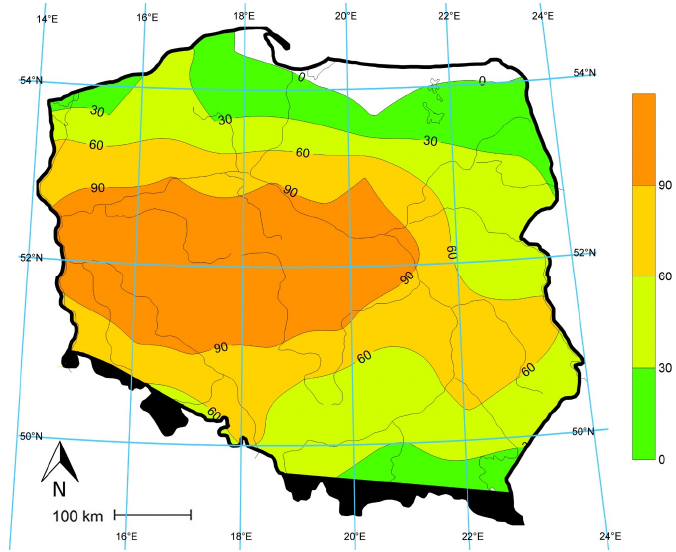
Figure 2. Duration of sequences of days with low precipitation frequency during summer (June–August) 2019. White color—phenomenon does not occur. Black color areas above 500 m above sea level. 3.3. Percentage of Normal Rainfall June–August 2019 From June to August 2019 in the South Baltic Lakes belt and the Central Polish Low- lands, precipitation totals were 30–60% of normal with a minimum of 30.1% in Pozna ń . Slightly higher values of precipitation occurred in the western part of the South Baltic Coast and Lake Districts belt within 70–90% of the norm. Values exceeding 90% of the precipitation norm occurred in the southern part of the Sudety Mountains with the Sude- ten Foreland, in the northern part of the Ma ł opolska Upland, in the western part of the Outer West Carpathians, and in the eastern part of Poland. The highest values of precipi- tation were recorded in the eastern part of the South Baltic Coast, the Eastern Baltic Coast, and the Podlasie–Byelarus Uplands within 100–125% of the norm. The average precipita- tion in Poland was only 66.5% of the norm (Figure 3). 3.4. Climate Water Balance (CWB) for June, July, August with Aspects of Regional Variation In June 2019, the greatest water deficit occurred in the central Poland belt, especially its central and western parts with a maximum in Pozna ń at 176.6 mm. The water deficit decreased towards the north, south, and east. The lowest values of water deficit occurred in Eastern Baltic Coast and Lake Districts with the minimum of − 71.3 mm in K ę trzyn. Lower de fi cit values were recorded in southern Poland with a minimum of − 34.1 mm near Lesko. The mean value of CWB in Poland was − 129 mm (Figure 4a). In June 1981–2010, the highest water deficit occurred in central Poland, especially in its central and western part with its maximum in Pozna ń at 106.7 mm. Water deficit decreased towards the north and south. The smallest deficit values occurred in the Eastern Baltic Coast and the Lake